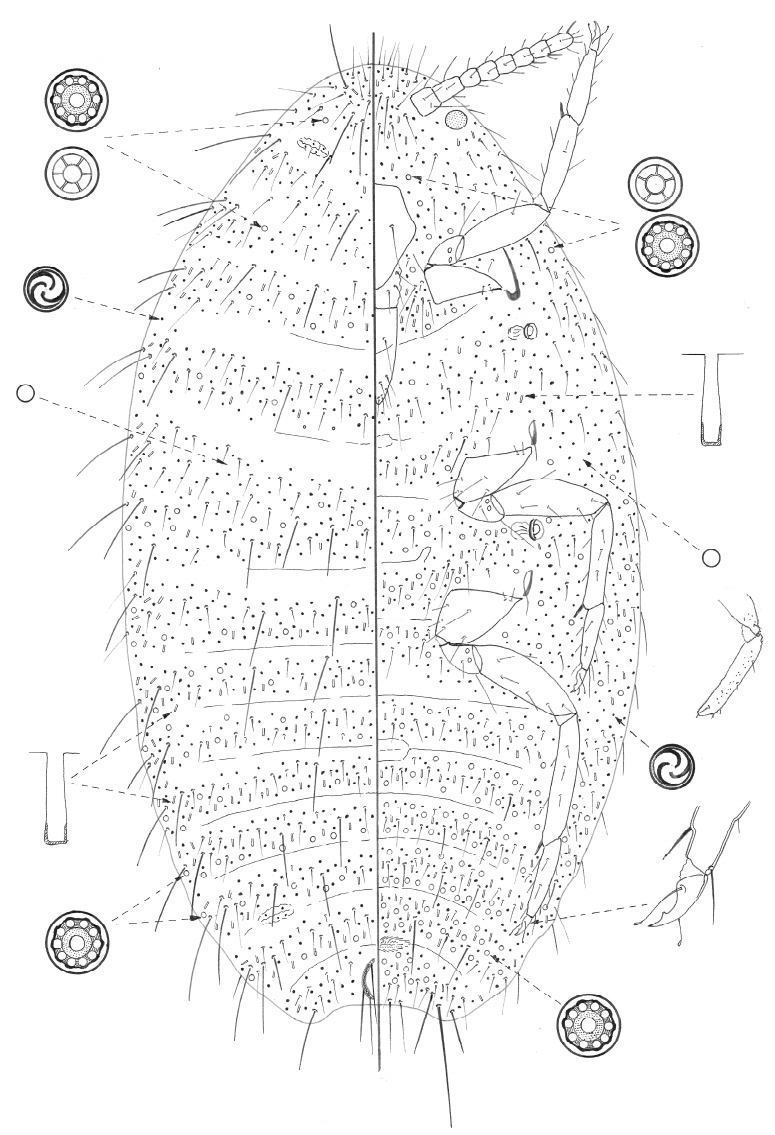
Figure 1. Adult female of Mirococcus capeverdensis Ł agowska and Hodgson sp.n. Material studied : Holotype: Left label: Cape Verde Is / Sal, St. Maria / Campylanthus glaber / 14.ii.2018 / B. Ł agowska; right label: Mirococcus / capeverdensis / Ł agowska & / Hodgson /